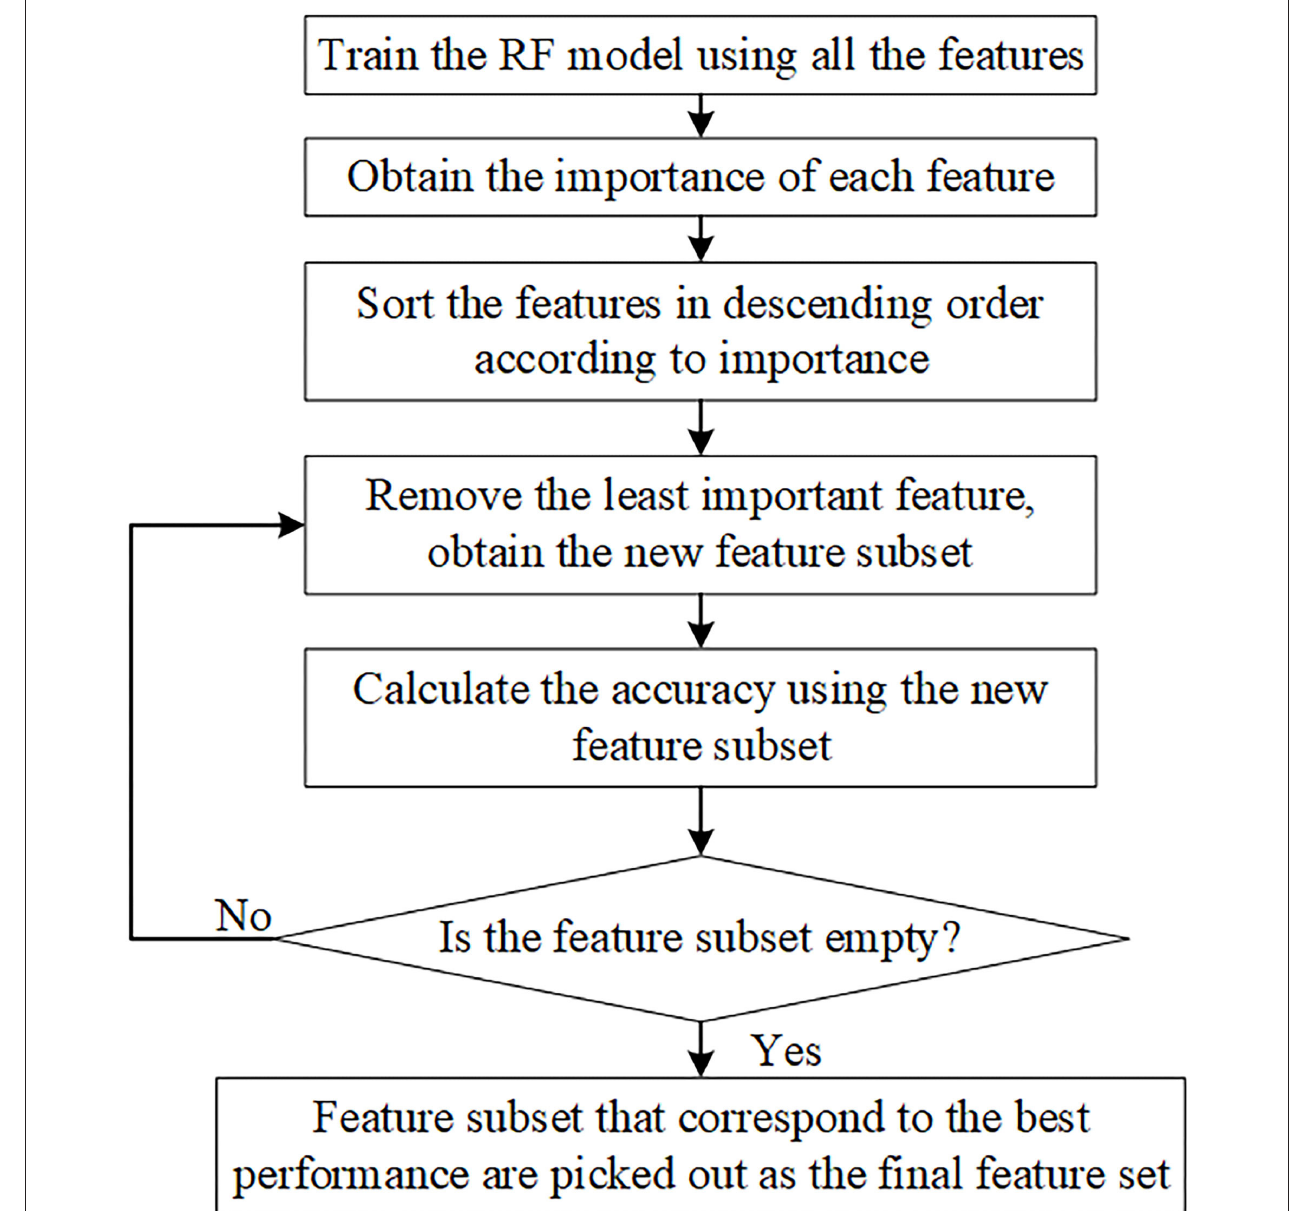
FIGURE 3 | RF-RFE algorithm